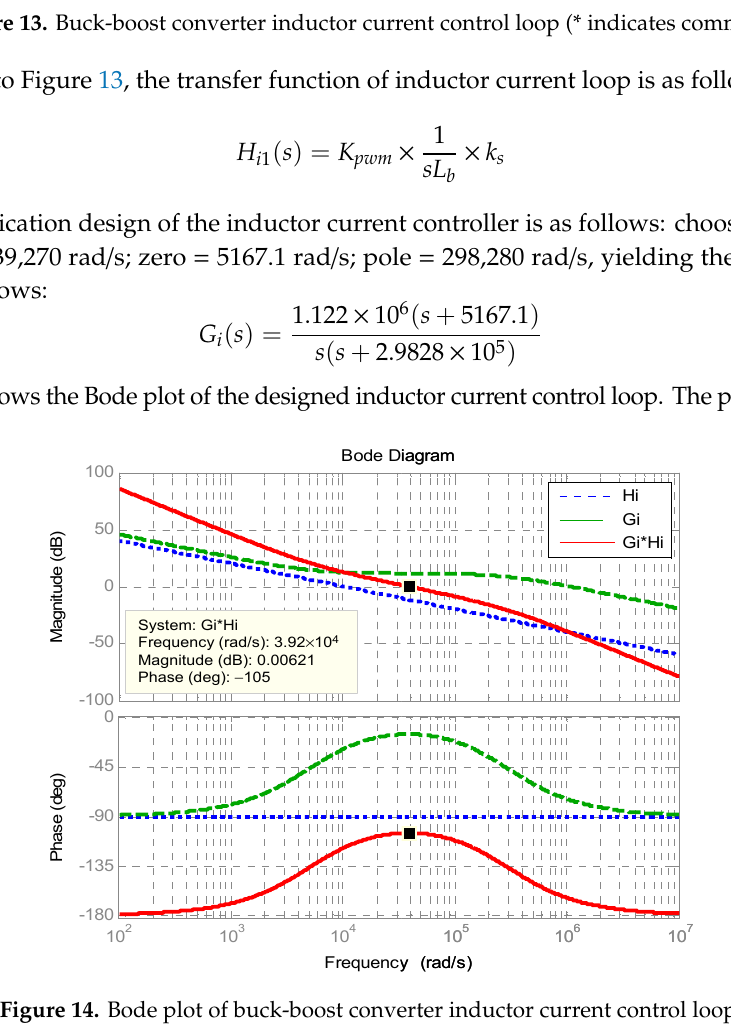
Figure 13. Buck-boost converter inductor current control loop (* indicates command).